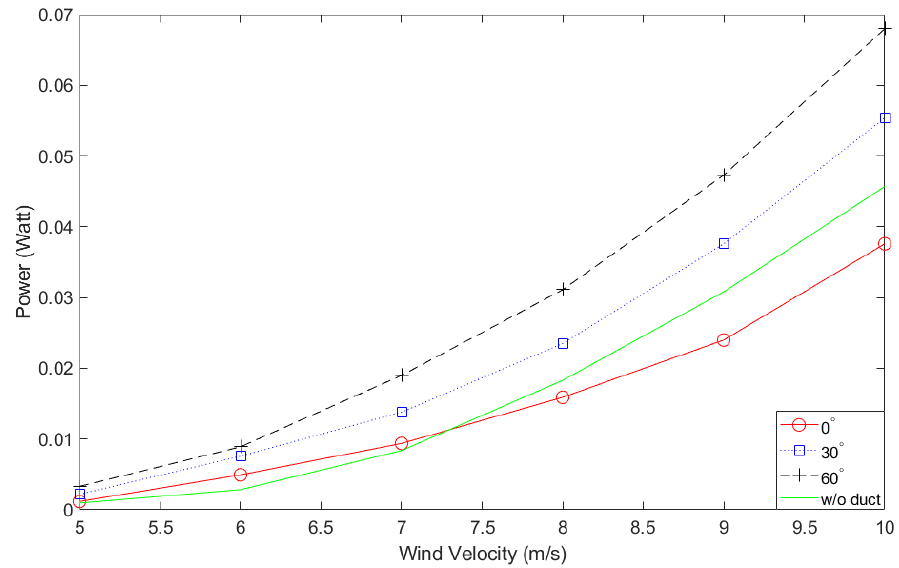
Figure 10. Power generation performance for the brim angle of the